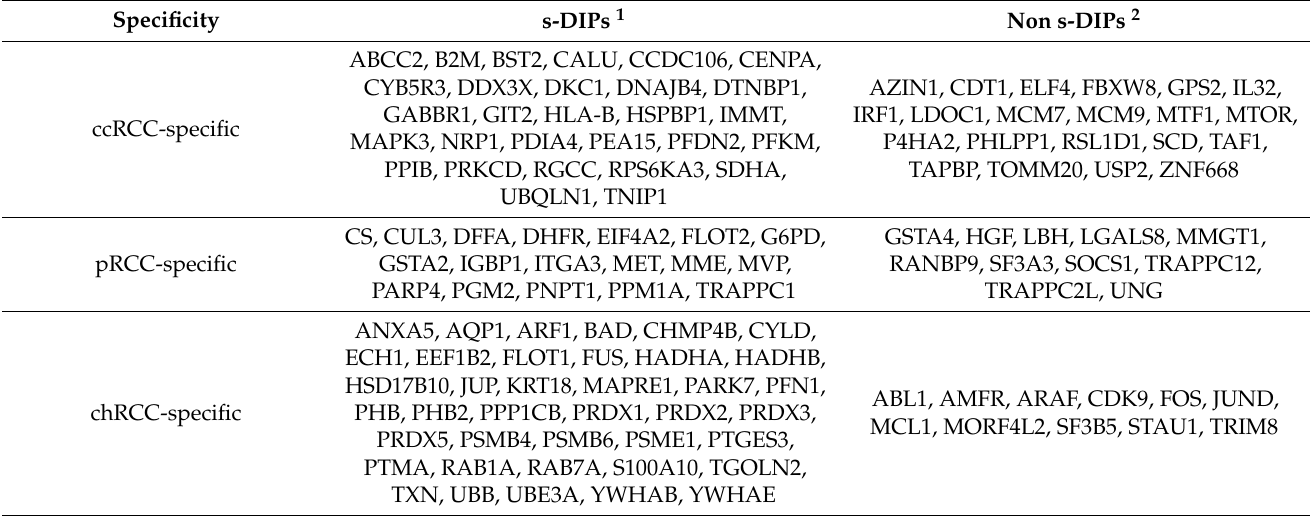
Table 1. Differentially interacting proteins (DIPs) specific to RCC subtypes.